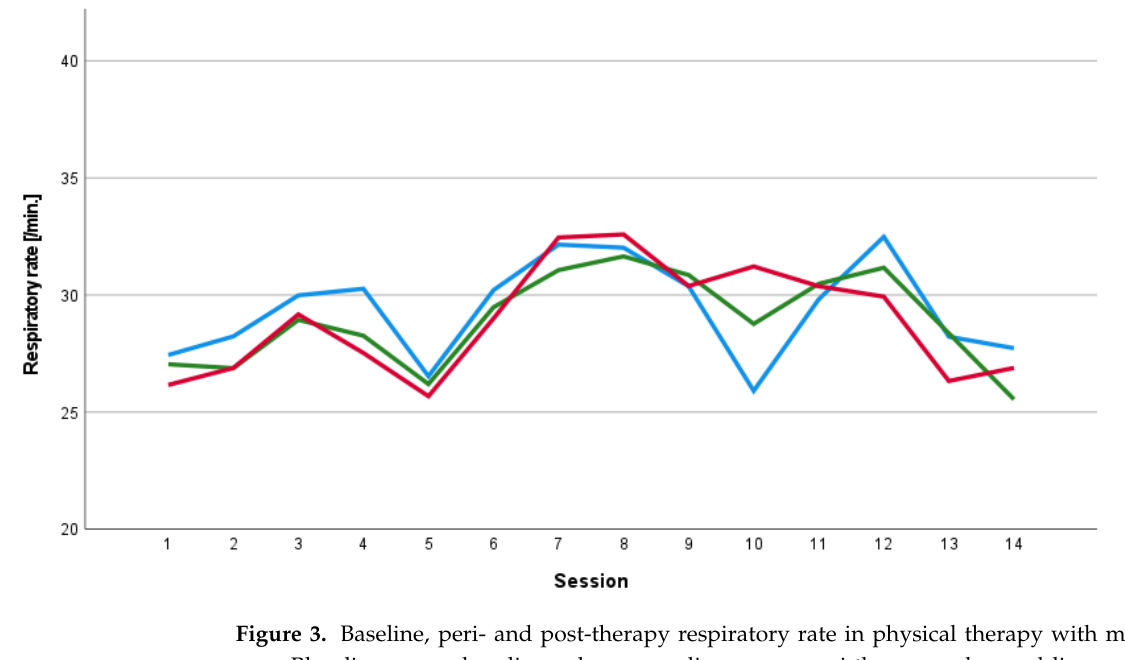
Figure 3. Baseline, peri- and post-therapy respiratory rate in physical therapy with music therapy. Blue line: mean baseline value, green line: mean peri-therapy value, red line: mean post-therapy value.